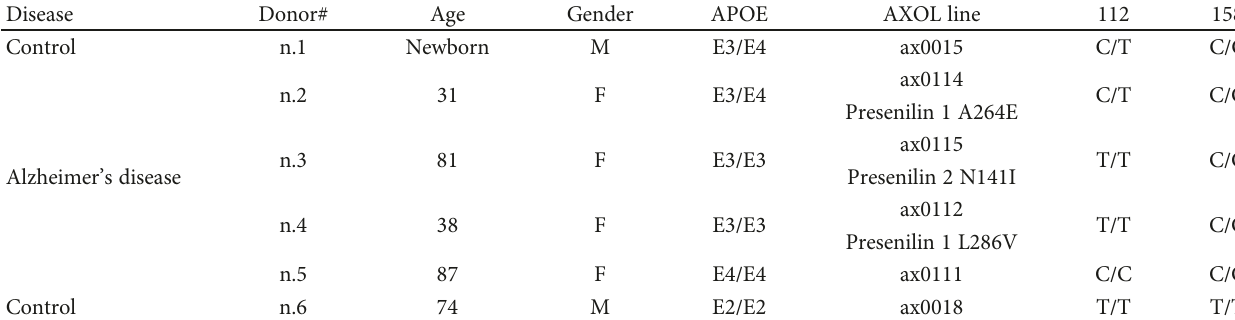
Table 1: Genetic characteristics of the human progenitor stem cells used in our experiments.